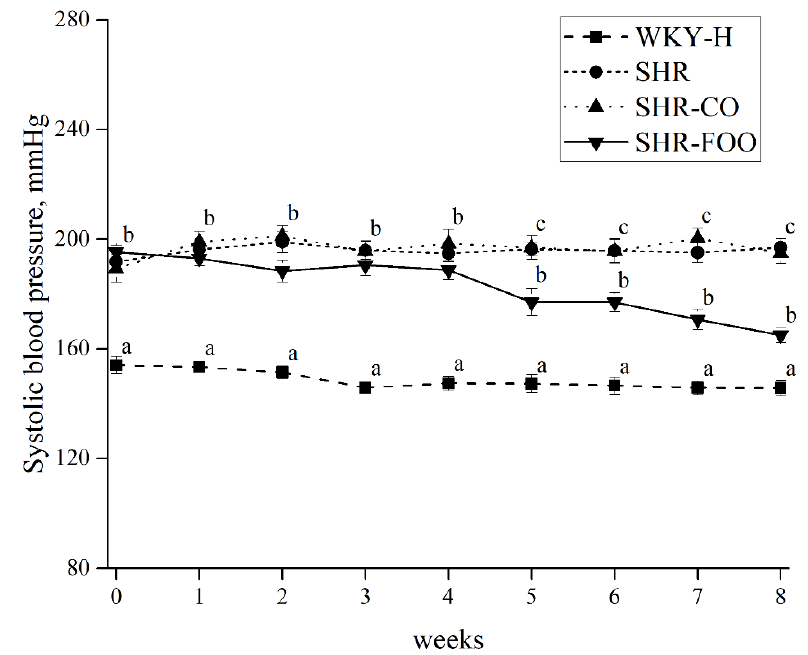
Figure 2. Time course of tail SBP measured by tail-cuff plethysmography in the experimental groups. Data are mean ± SEM. The ANOVA test was used to compare results among groups for normal distribution variables. The Bonferroni post hoc test was used for multiple comparisons among groups.